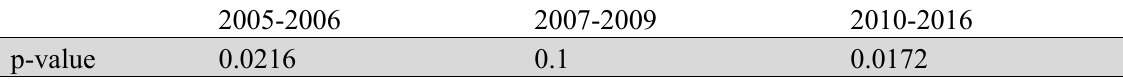
KPSS Test of the efficiency measures for prior, during and post the financial crisis